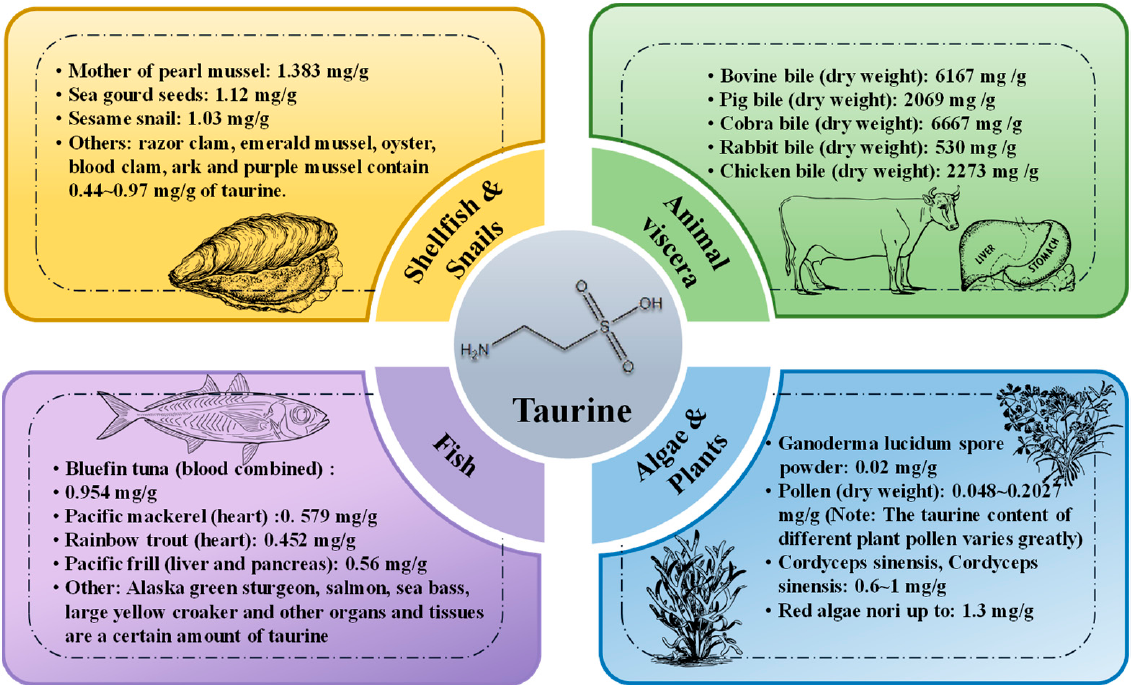
Figure 2. Main dietary sources of taurine and the proportion of taurine in each food [43–46].